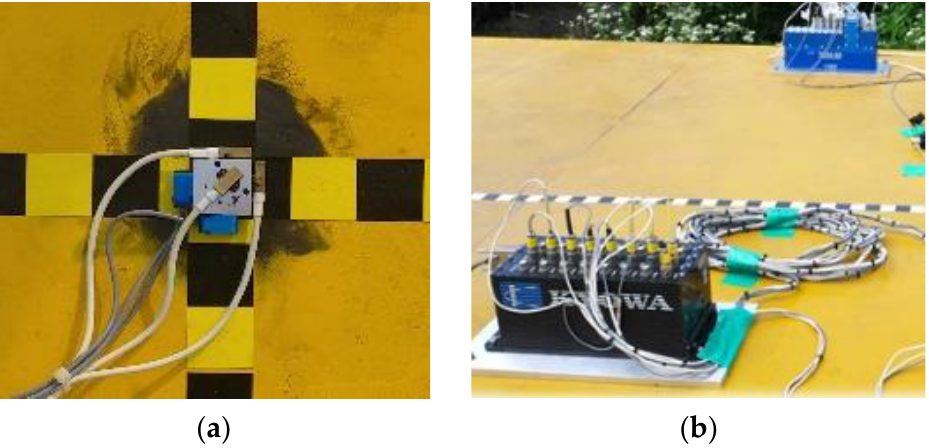
Figure 8. Data acquisition system for the test car: ( a ) accelerometers and gyro sensors for the 6-DOF and ( b ) shock-resistant datalogger.